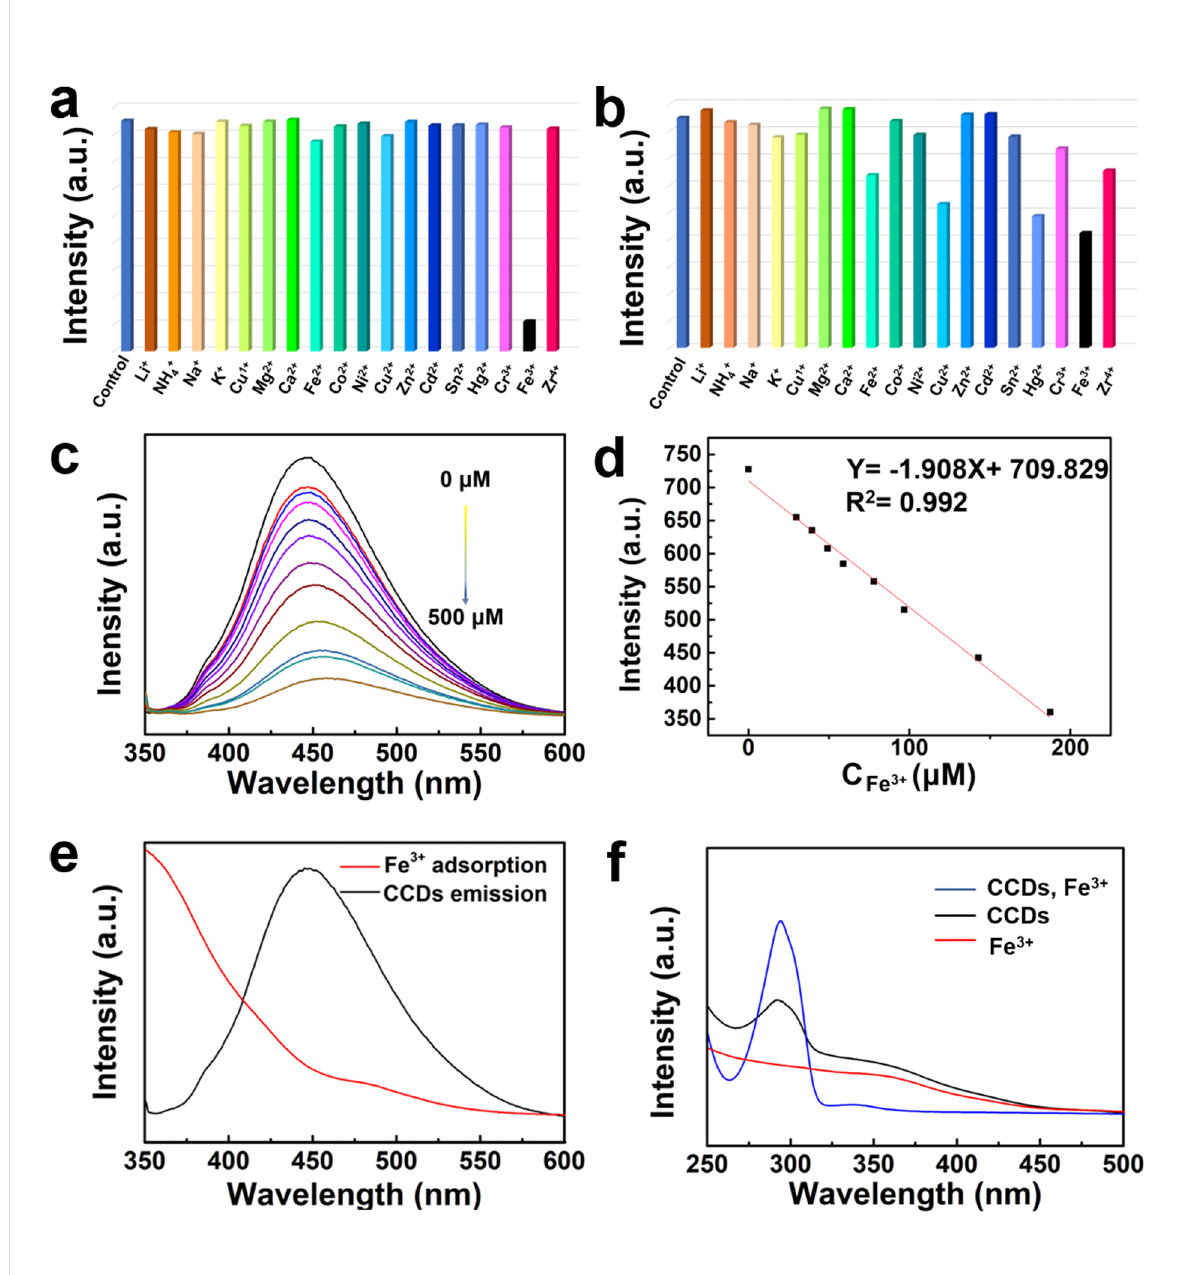
Figure 3: Fluorescence quenching degrees of a) CCDs and b) CN-dots in the presence of different metal ions. The concentrations of metal ions were 400 μМ . c) Fluorescence spectra of a CCDs system in the presence of different concentrations of Fe 3+ ions (0–500 μ M). d) Linear curve of the rela- tive fluorescence intensity versus the concentrations of Fe 3+ ions. Experimental conditions: Slit widths: Ex. 5 nm, Em. 5 nm; λ ex = 340 nm. e) Spectral overlap of the UV–vis absorption spectrum of Fe 3+ (red line) and fluorescence spectrum of CCDs (black line). f) UV–vis spectra of CCDs, Fe 3+ , and CCDs after the sensing of Fe 3+